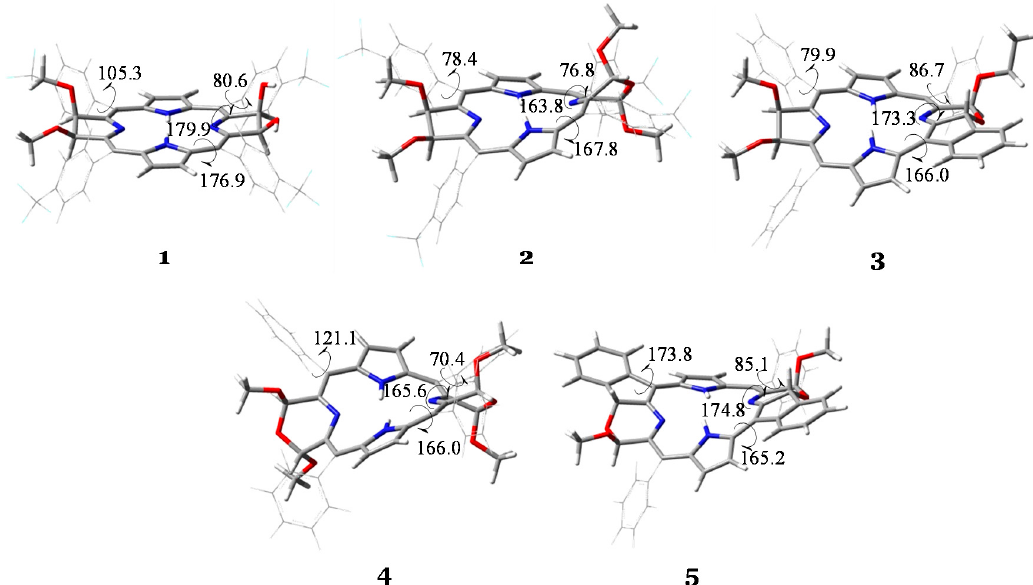
Figure 1. Optimized structures of compounds 1 – 5 computed at B3LYP/6-31G* level of theory. Torsion angles, φ 1 , φ 2 , φ 3 and φ 4 are reported in degrees.